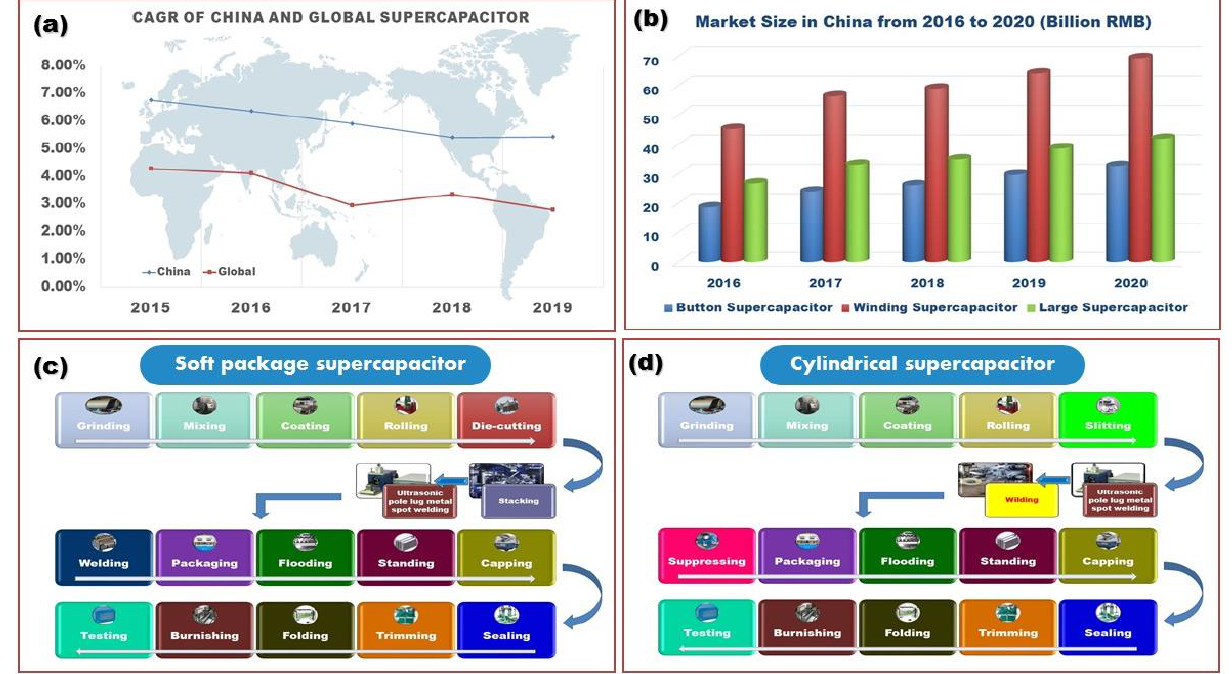
Figure 4. ( a ) Comparison of the scale growth of China and the global supercapacitor industry, ( b ) market size of three major types of supercapacitor in China from 2016 to 2020, ( c ) and ( d ) Manufacturing process flow chart of soft package and cylindrical supercapacitor, respectively.